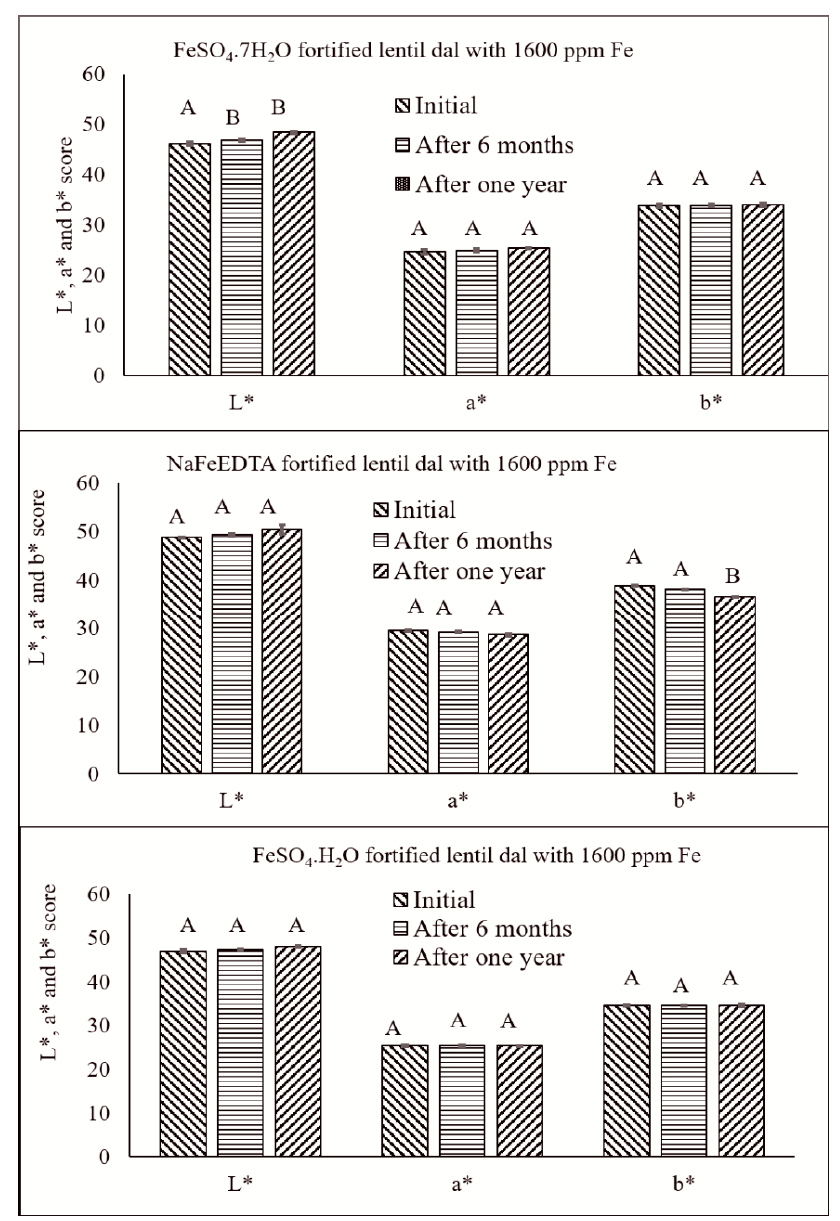
Figure 7. Effect of storage time on changes in L*, a* and b* score of football lentil samples fortified with 1600 ppm of Fe using FeSO 4 ·7H 2 O, NaFeEDTA and FeSO 4 ·H 2 O. Different letters within each figure represent significant differences ( p < 0.05).